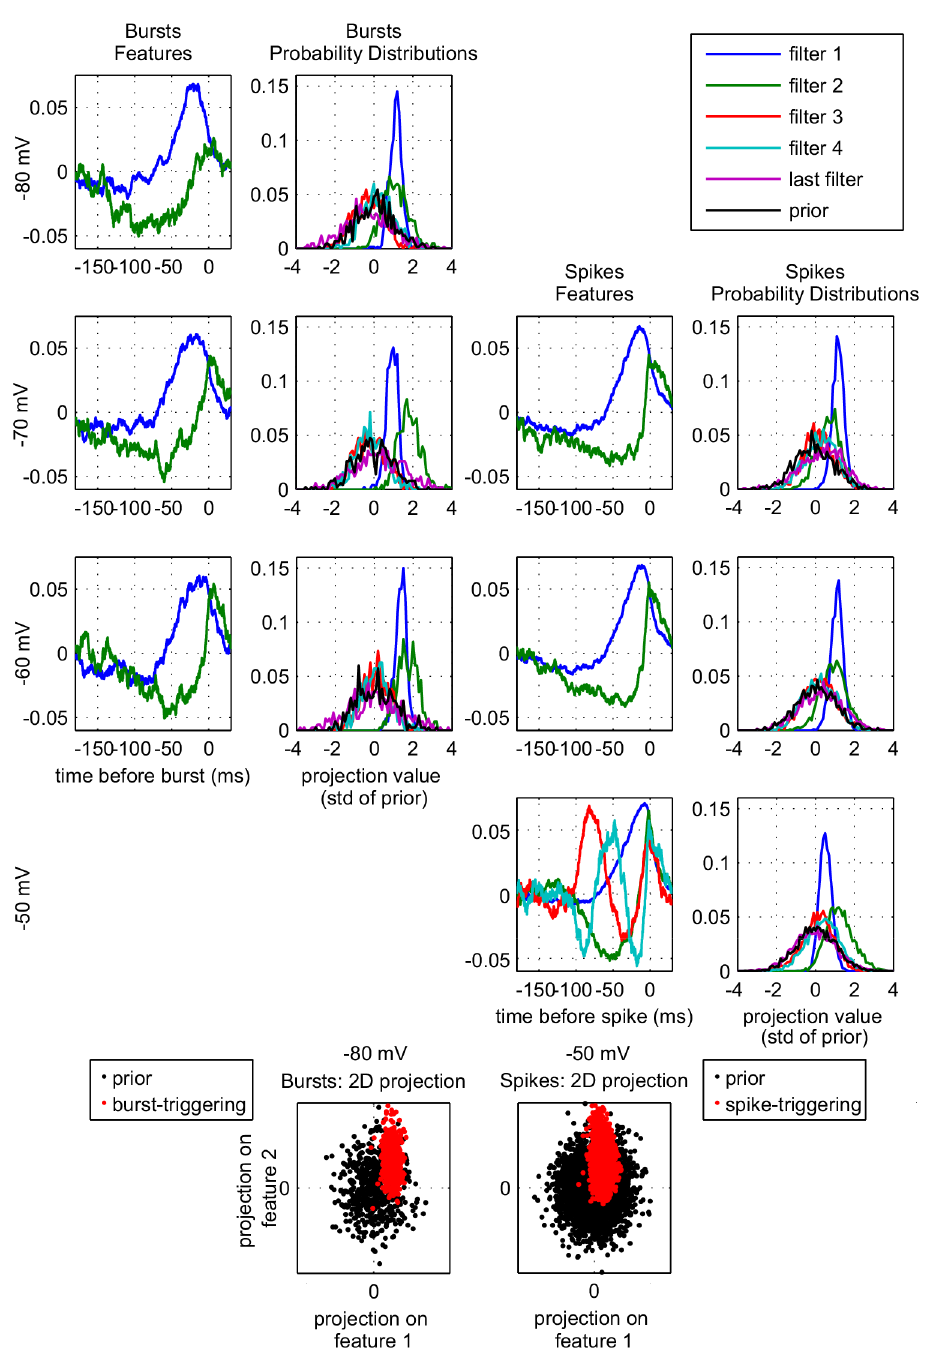
Fig 8. Event Triggered Covariance (ETC) of membrane potential and injected current. ETC was calculated for bursts (left two columns) and isolated spikes (right two columns) for four different membrane states (top four rows). ETC needs far more realizations than ETA, so at −80 mV, where burst dominate, we can only give results for bursts. While at −50 mV, where bursts are rare and spikes dominate, we can only give results for spikes. Only filters for which the probability distribution was substantially different from the prior, are shown. In S3 Fig we show the corresponding eigenvalues. Bottom row: projections along the first two features for bursts at a membrane state of −80 mV (left) and for spikes at a membrane state of −50 mV